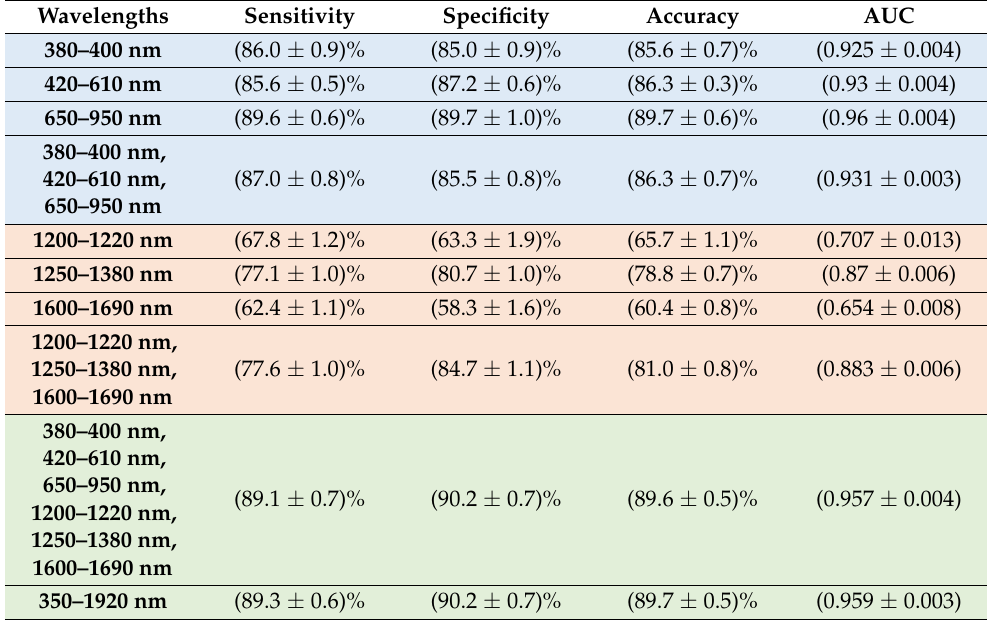
* Results corresponding to 2-fold cross-validation from 20 iterations of random sampling of training and test